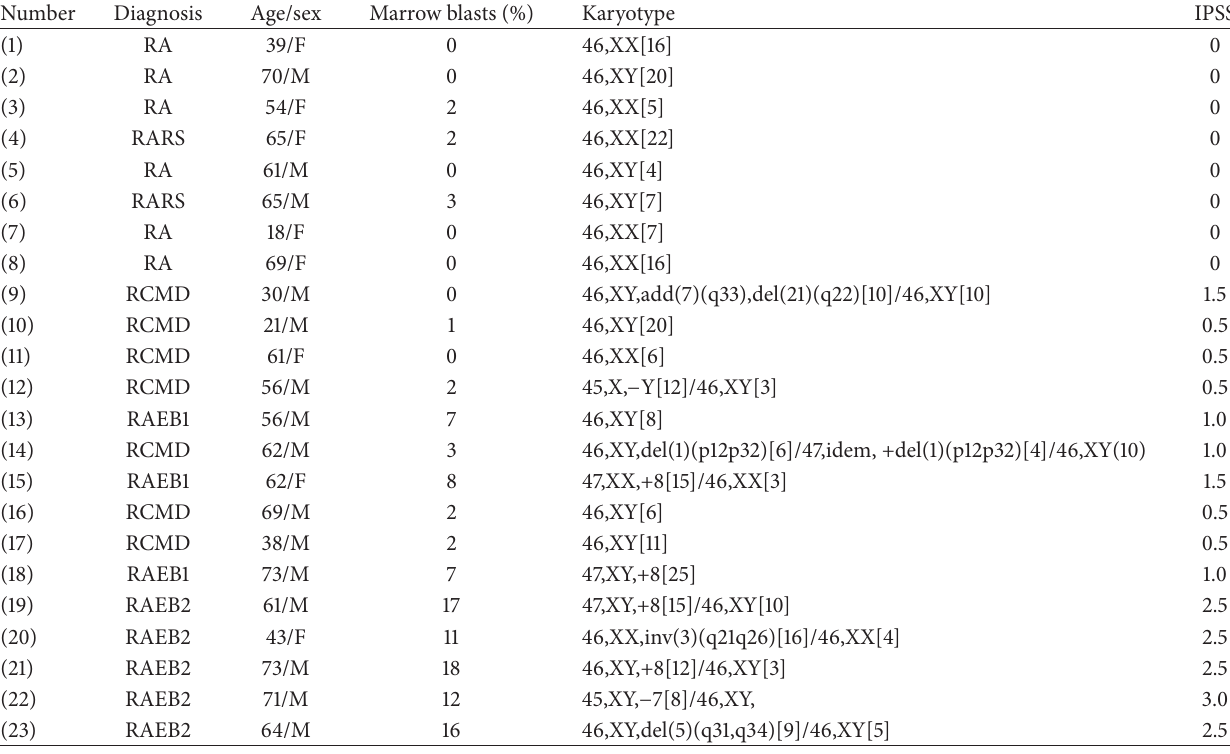
Table 1: The characteristics of myelodysplastic syndrome patients.